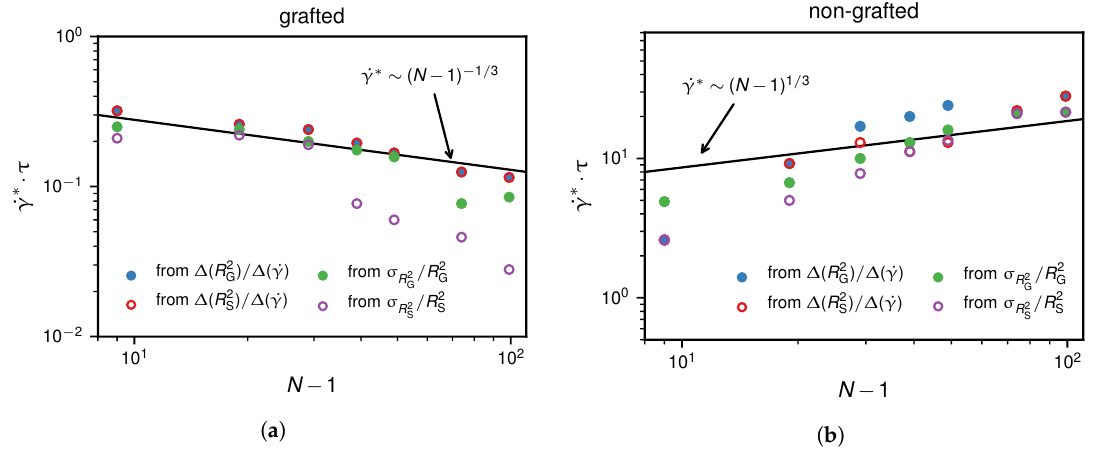
Figure 5. The critical shear rate, ˙ γ ∗ , for the grafted and non-grafted scenarios as determined by four different criteria. We present the numerical derivatives and the normalized standard deviations of R 2 and R 2 , indicated by dashed vertical lines in Figures 2 and 4, as a function of N − 1. The scaling G S predictions according to Equation (12) are shown as solid lines.